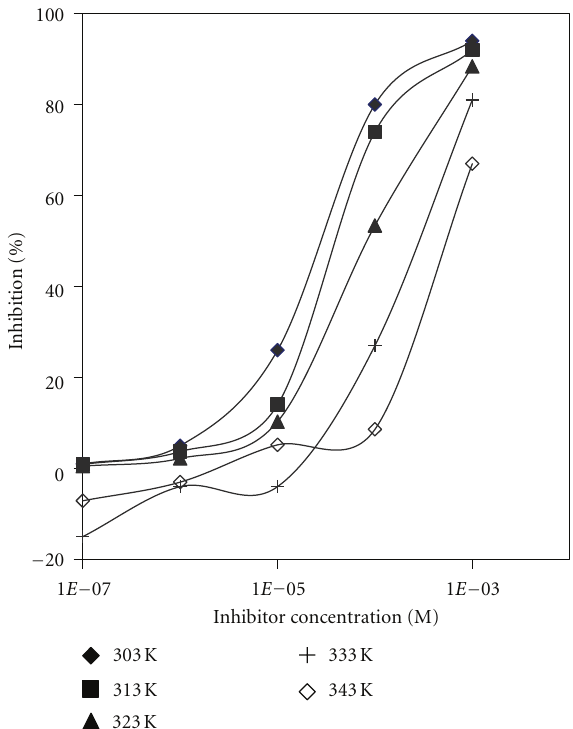
Figure 4: E ff ect of temperature on the corrosion rate of mild steel in 1M HCl solution with and without the presence of various concentrations of trans-4-hydroxy-4 (cid:2) -stilbazole